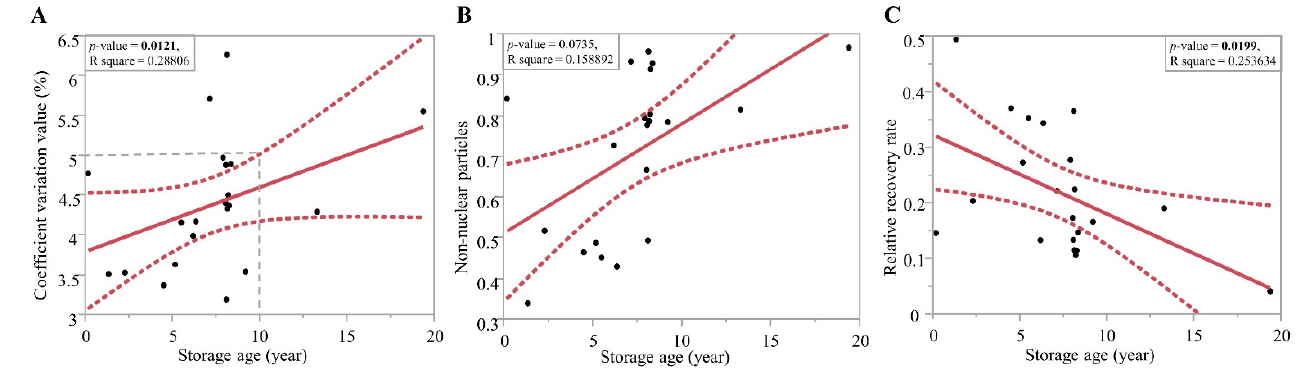
Figure 3. Linear regression of time and ( A ) coefficient variation value, ( B ) non-nuclear particles value, and ( C ) relative recovery rate of 4 °C-stored Sphaeropteris lepifera spore collections.